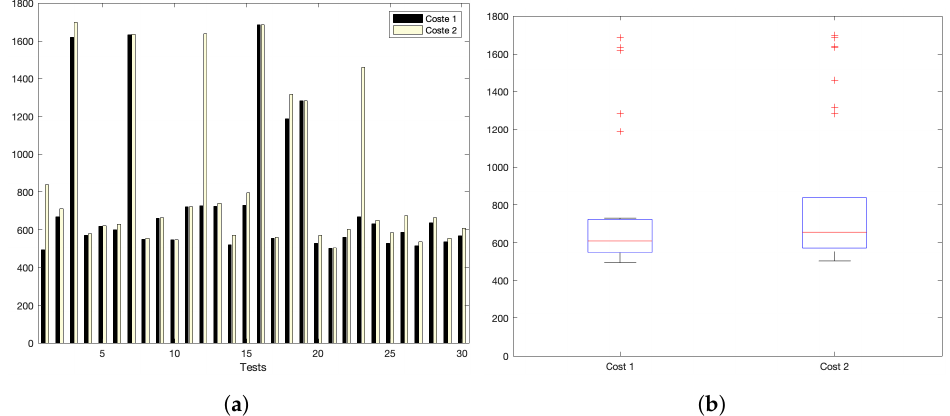
Figure 8. High request-rate scenario: ( a ) individual test values for cost 1 and cost 2 ; ( b ) summary values. Table 4. Latency summary for all scenarios (in miliseconds).